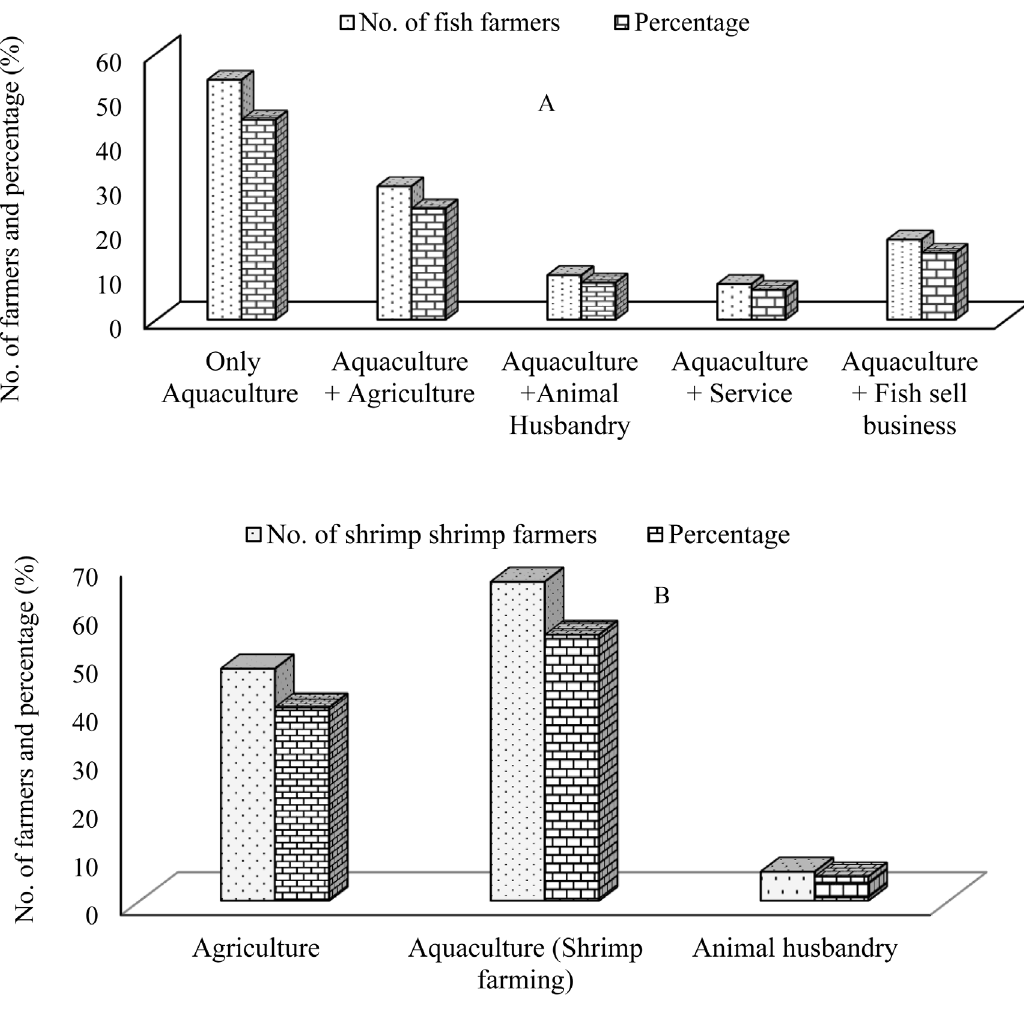
Fig. 1. Sources of livelihood of the farmers (A (cid:2) Site-FW; B –